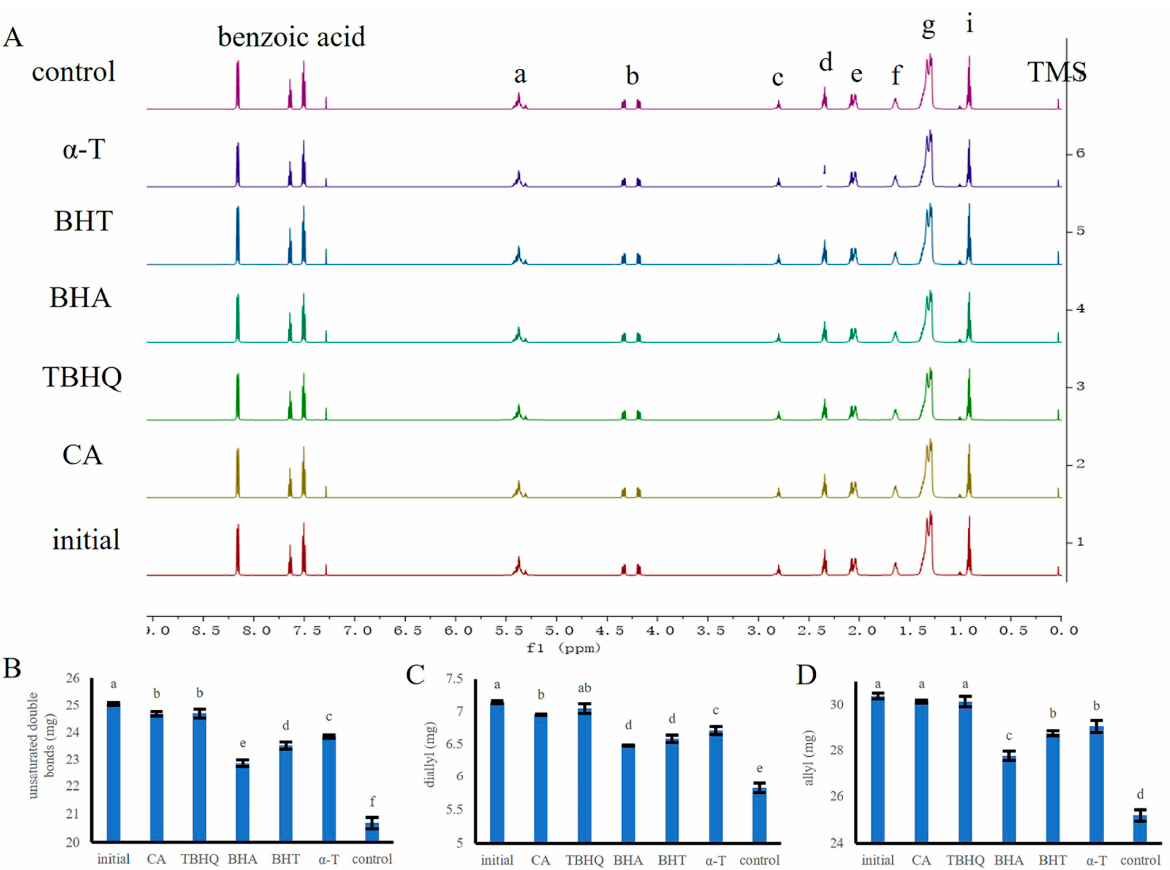
Figure 5. 1 H-NMR analyses of Aoil at the beginning and storage at 60 ◦ C for 5 h. ( A ), 1 H-NMR spectrum of Aoil enriched with different antioxidants. a: unsaturated double bond; b: glyceryl; c: diallyl; d: alpha carbonyl peri-methyl; e: allyl; f: β -carbonyl vicinal methyl; g: saturated methylene; i: terminal methyl group (saturated acid, oleic acid, linoleic acid acyl). Quantification of unsaturated double bonds ( B ), diallyl ( C ), and allyl ( D ). a–f means with different superscripts differ significantly ( p < 0.05). Table 2. Chemical shift assignments of 1 H-NMR signals of oxidation products of